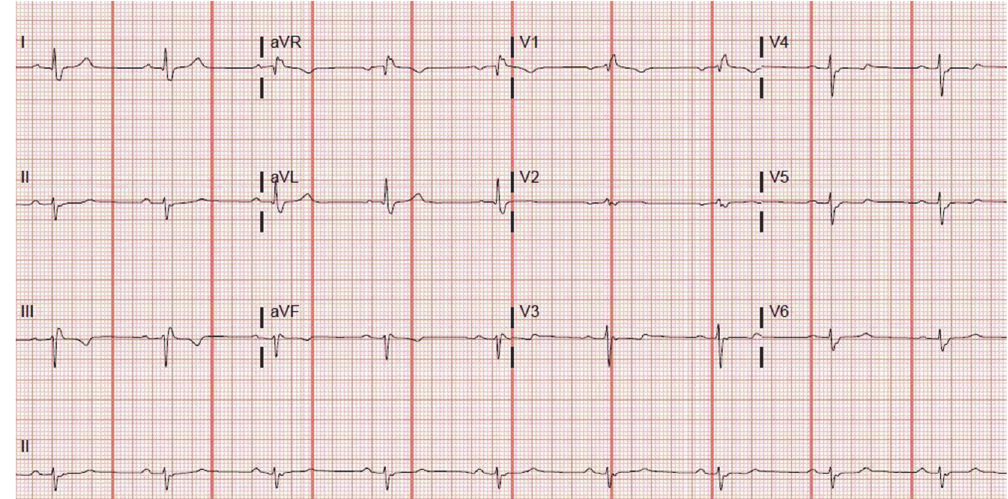
Figure 3: EKG showing sinus bradycardia with borderline AV conduction delay with RBBB